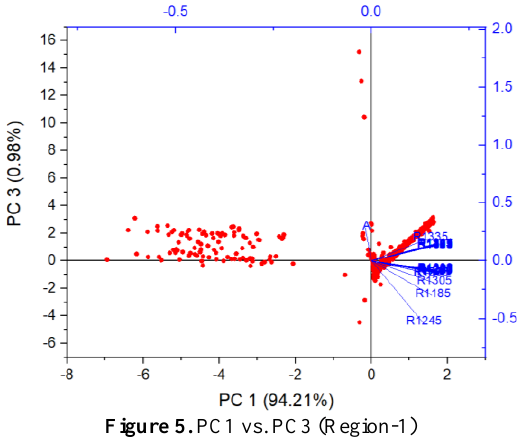
Figure 6. PC2 vs. PC3 (Region 1)